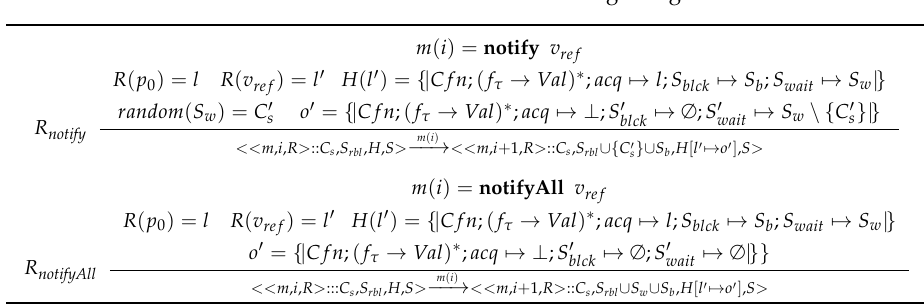
Table 10. Multi-threaded semantics: signaling.